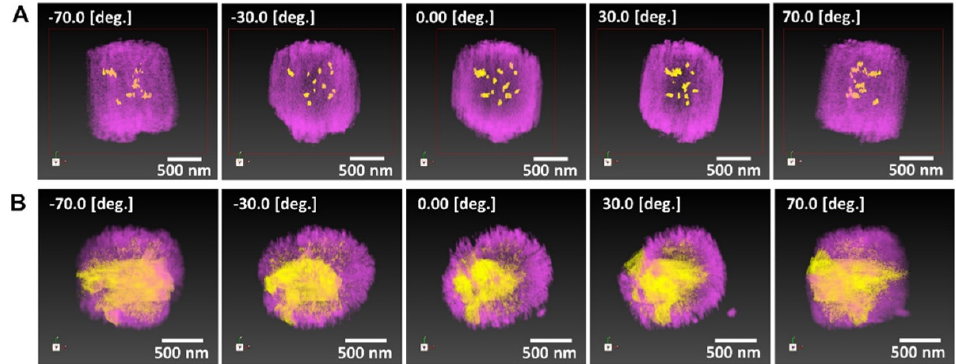
Figure 5. Three-dimensional pore visualization via the electron tomography with the tilting angles from − 70° to + 70° of the MOR zeolites before ( A ) and after ( B ) the NH 4 F treatment. Reprinted with permission from [49] . Copyright 2021 American Chemical Society.